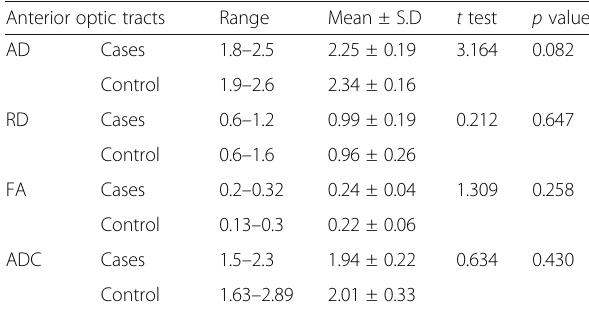
Table 6 A comparison between the DTI parameters (AD, RD, FA, ADC) of anterior optic tracts Anterior optic tracts